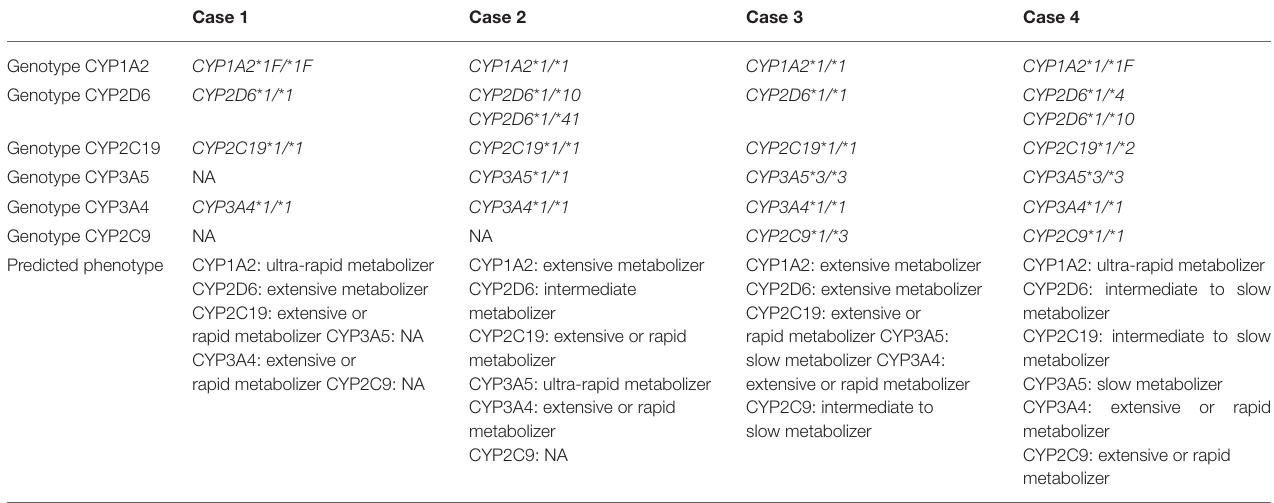
TABLE 1 | Pharmacogenetics testing for